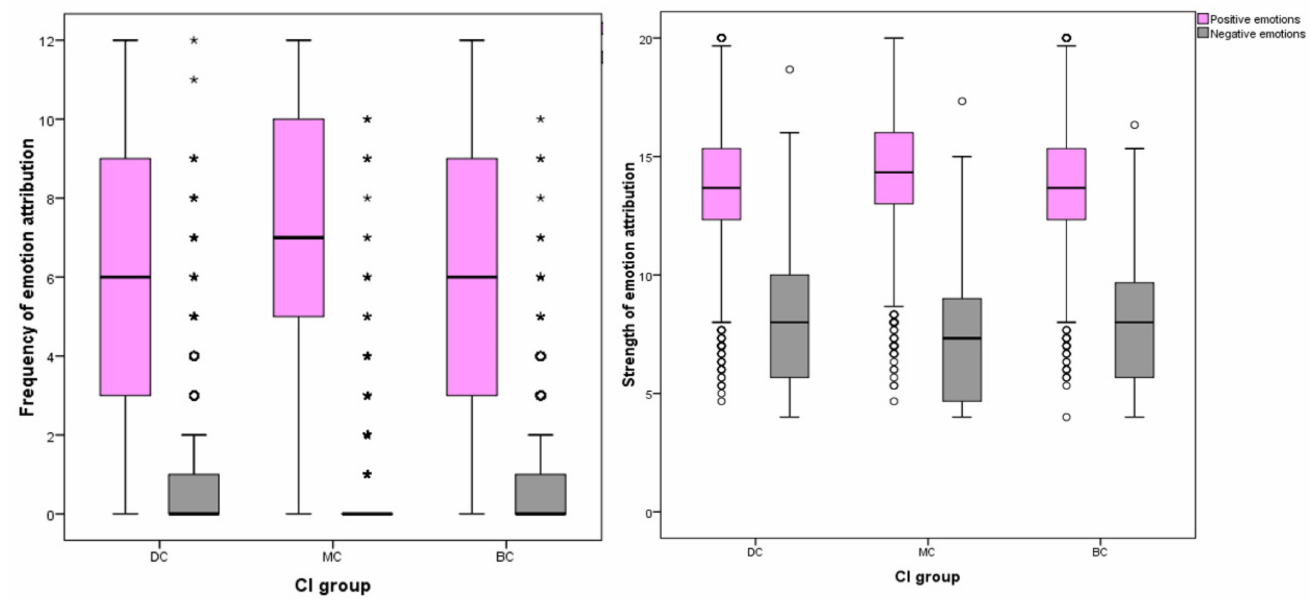
Figure 5. Box plot showing significant differences between positive and negative emotion frequency and strength of emotion attributions to CI groups of dog images. Differences between all groups were significant at the p = 0.05 level. Positive grouped variables included joy, compassion, empathy and affection; negative grouped variables included fear, sadness, spite and embarrassment. (* demotes statistically significant differences. ◦ denotes